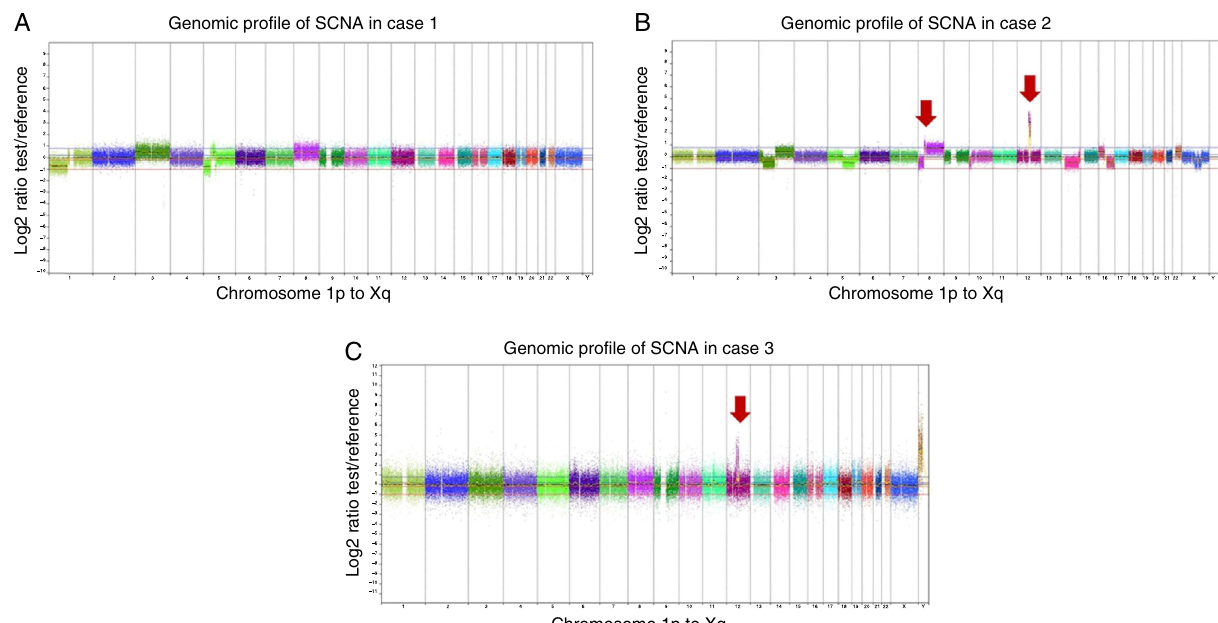
Copy number alterations detected by array-CGH in the CXPAs from RPA cases. Array-CGH genomic profile exhibiting the identified copy number alterations of case 1 (A), case 2 (B) and case 3 (C). The x -axis represents probes ordered according to their genomic position from chromosomes 1p to Xq (each chromosome is labeled with a different color). The y -axis denotes the log 2 test/reference values (genomic gains and losses are plotted above or below the 0 baseline, respectively; images adapted from the software Nexus Copy Number 7.0, Biodiscovery). The arrows indicate the high copy gains (amplifications).